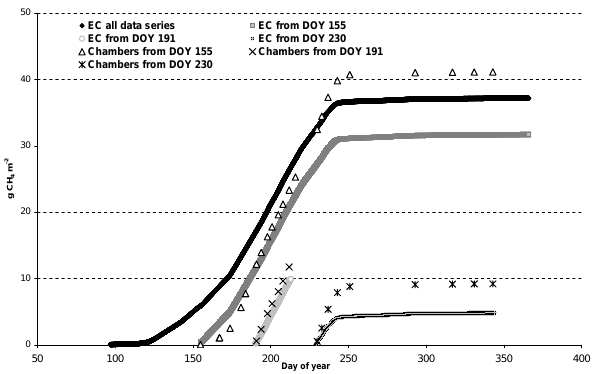
Fig. 6. Seasonal integrals of CH 4 fluxes measured with eddy covari- ance and with chambers (during all the experimental period, from DOY 155 and periods DOY 191-213 and DOY